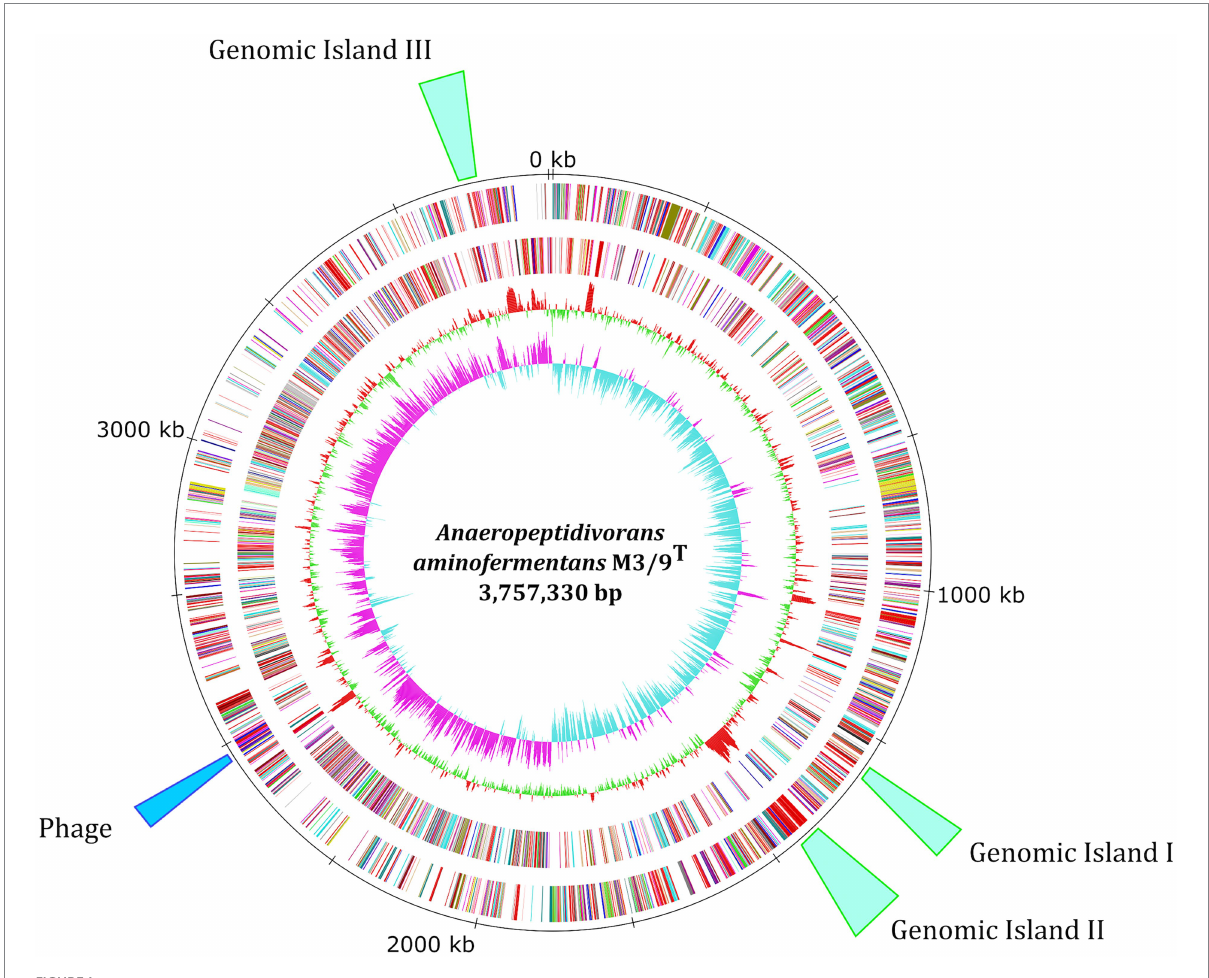
FIGURE 1 Circular representation of the A. aminofermentans M3/9 T chromosome. From the inner to the outer circle: Circle 1, GC skew; Circle 2, GC content; Circles 3 and 4, predicted protein-coding sequences (CDS) transcribed clockwise (outer part) or anticlockwise (inner part). The CDSs are colored according to the assigned COG classes. Circle 5, genomic position in kb. Circle 6, predicted prophage cluster and three genomic island regions in the A. aminofermentans M3/9 T genome. The replication initiation gene dna A was chosen as the first gene of the